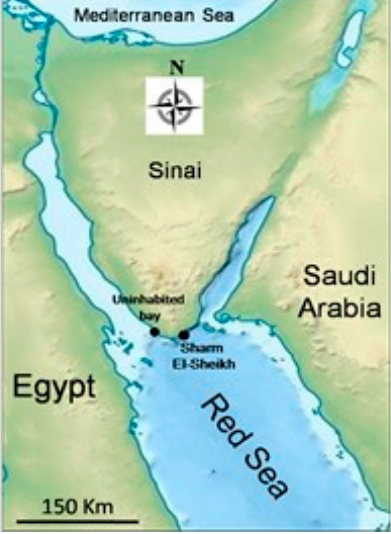
Figure 1. A map showing the locations of Sharm El-Sheikh, South Sinai, Egypt, and the uninhabited bay (45 km west of Sharm El-Sheikh).